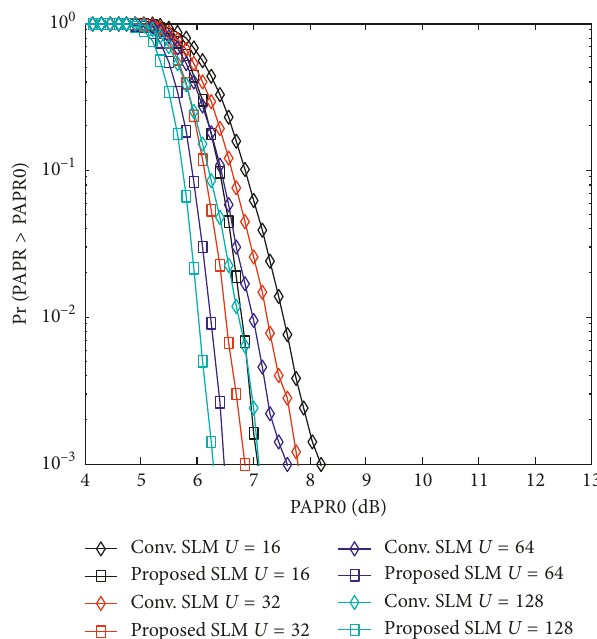
Figure 14: Comparison of SLM given in [5] with the proposed SLM for U � 16, 32, 64, and 128, N � 128, and 4-PSK.